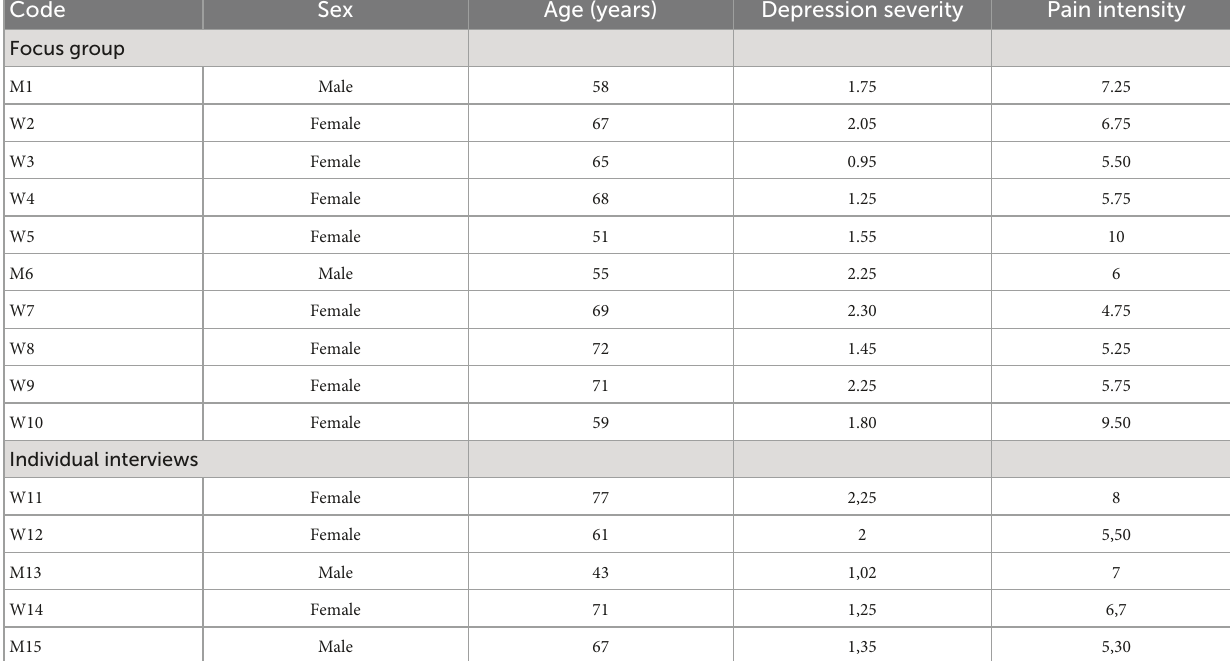
TABLE 4 Sociodemographics and clinical features of participants. Code Sex Age (years) Depression severity Pain intensity